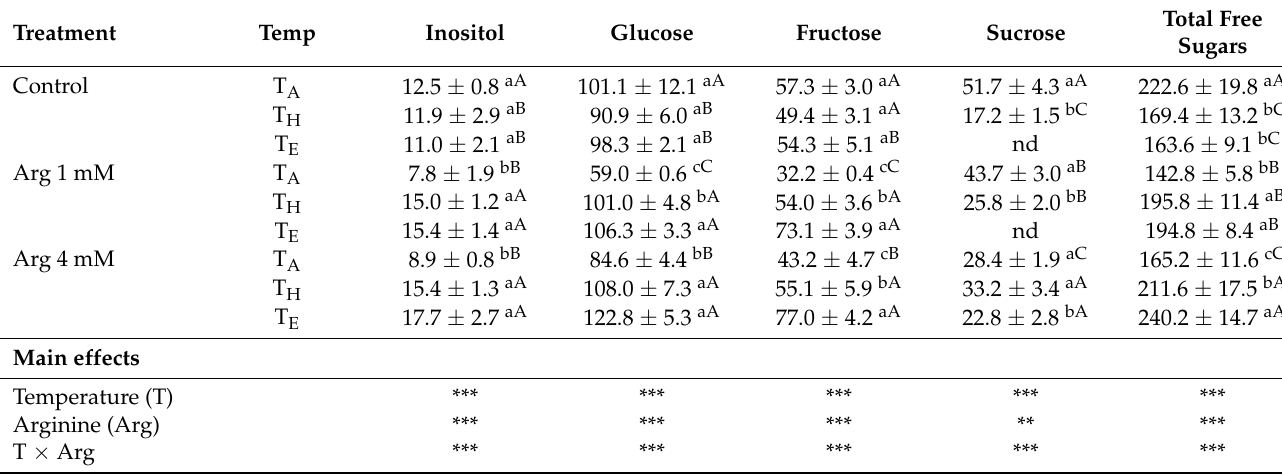
Table 5. Mean concentrations of sugars (g kg − 1 DW) of cauliflower florets affected by short-term heat stress and foliar arginine application.